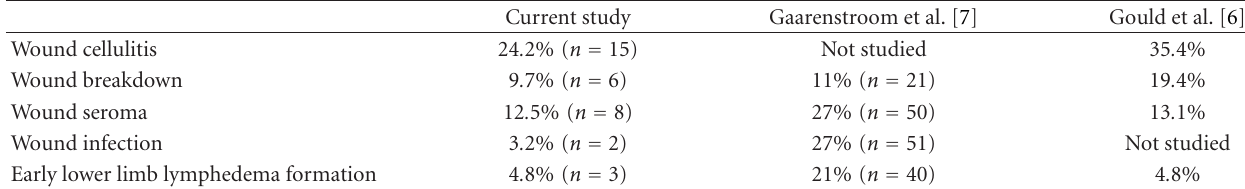
Table 2: Comparison between the incidence of wound complications in the current cohort and other published data